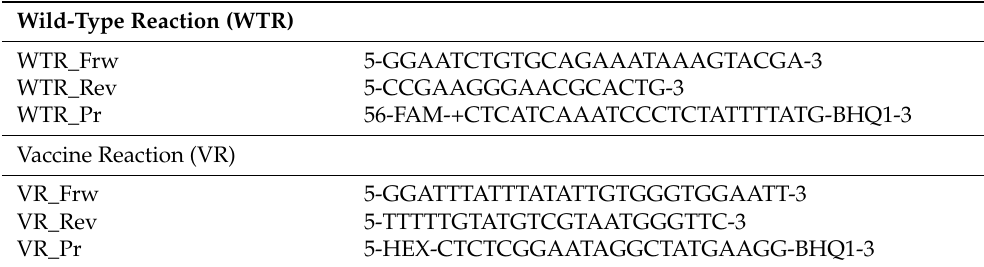
Table 1. Probe and primer sequences for the WTR and VR; +: an LNA nucleotide. Wild-Type Reaction